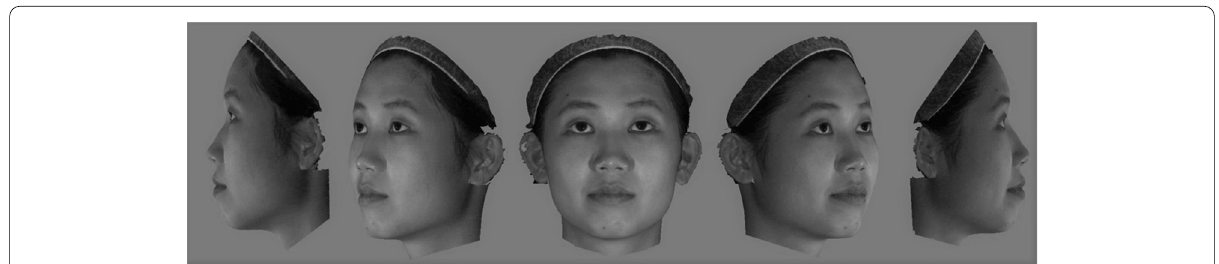
Fig. 1 3D photographs of a female model from different angles adopted from the video